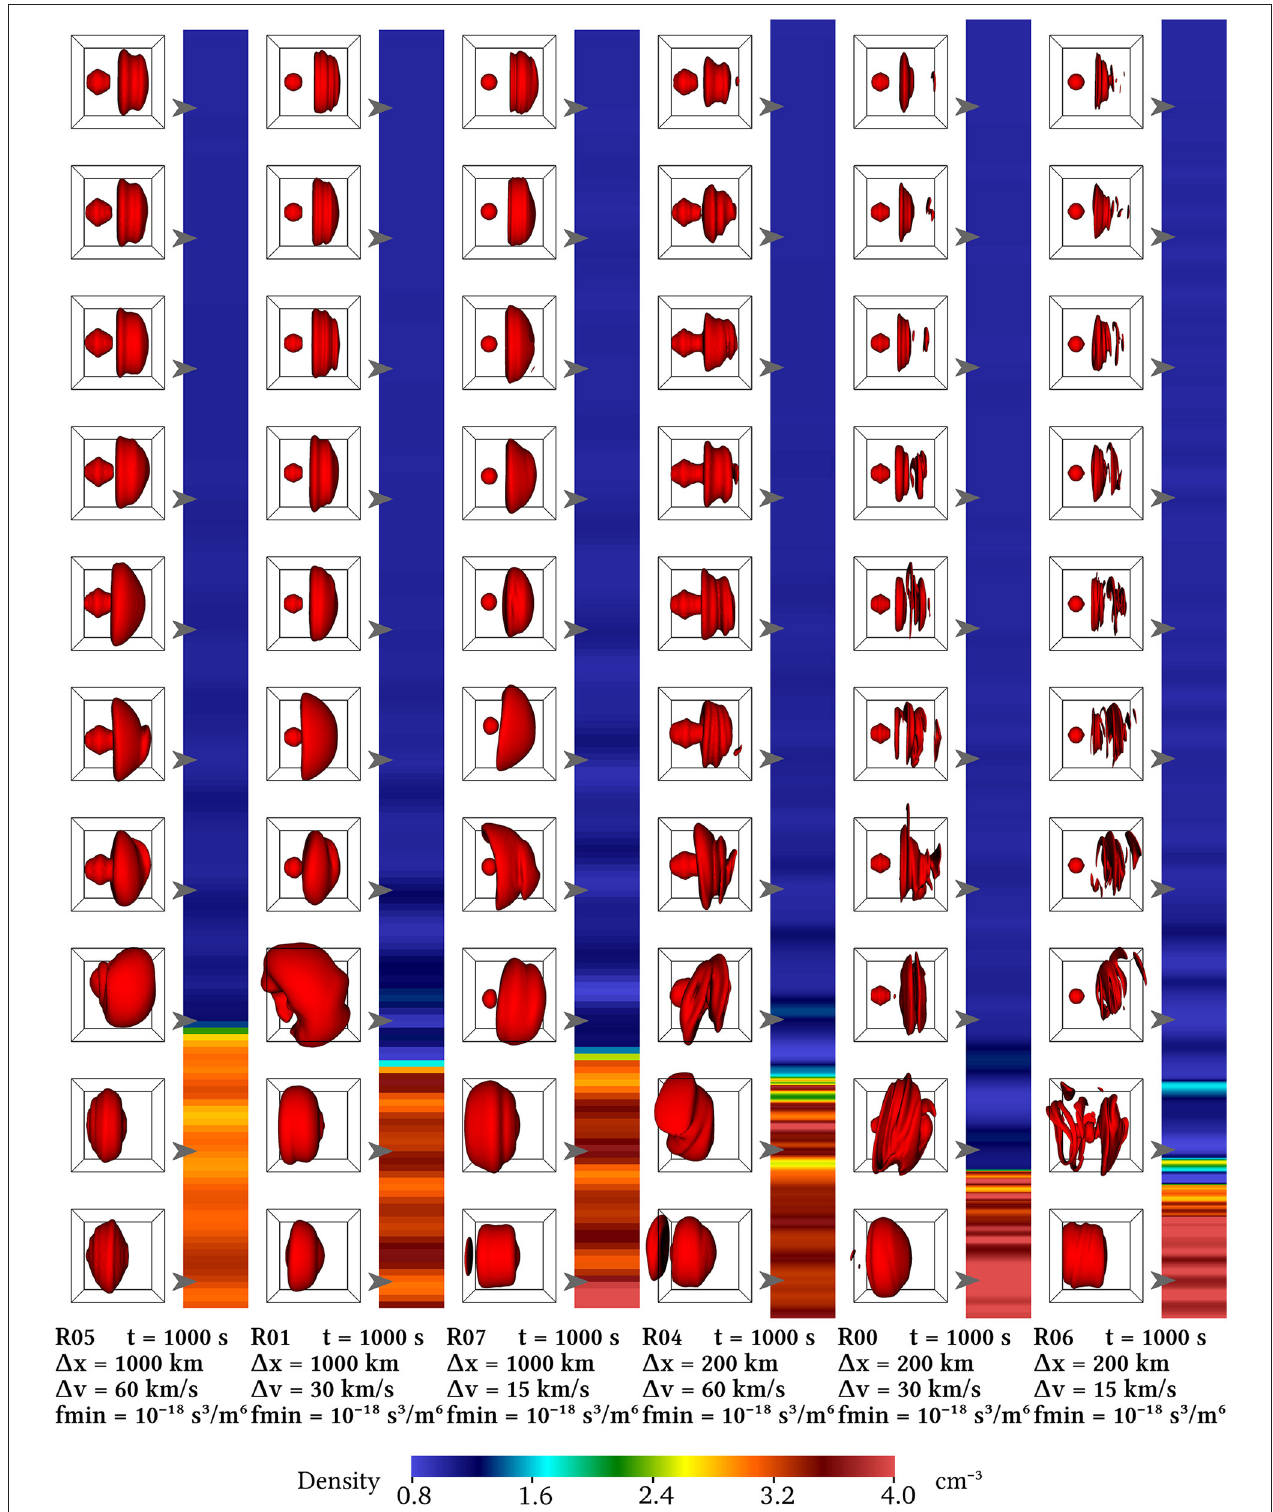
FIGURE 1 | Runs R05, R01, R07, R04, R00, and R06 showing the effects of varying 1 x and 1 v , along with corresponding Supplemental data Animation A1. The profiles of ion number density and temperature are shown in Figure 2 .